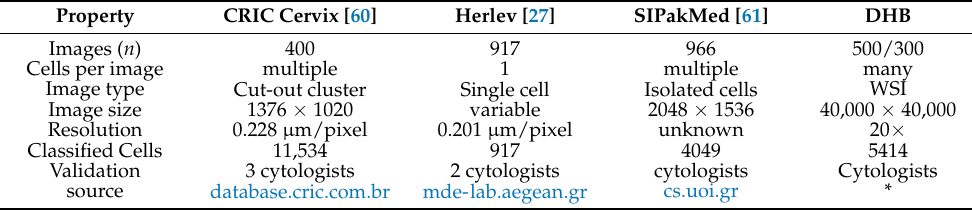
Table 8. Summary of the openly accessible Pap smear image datasets in the literature.